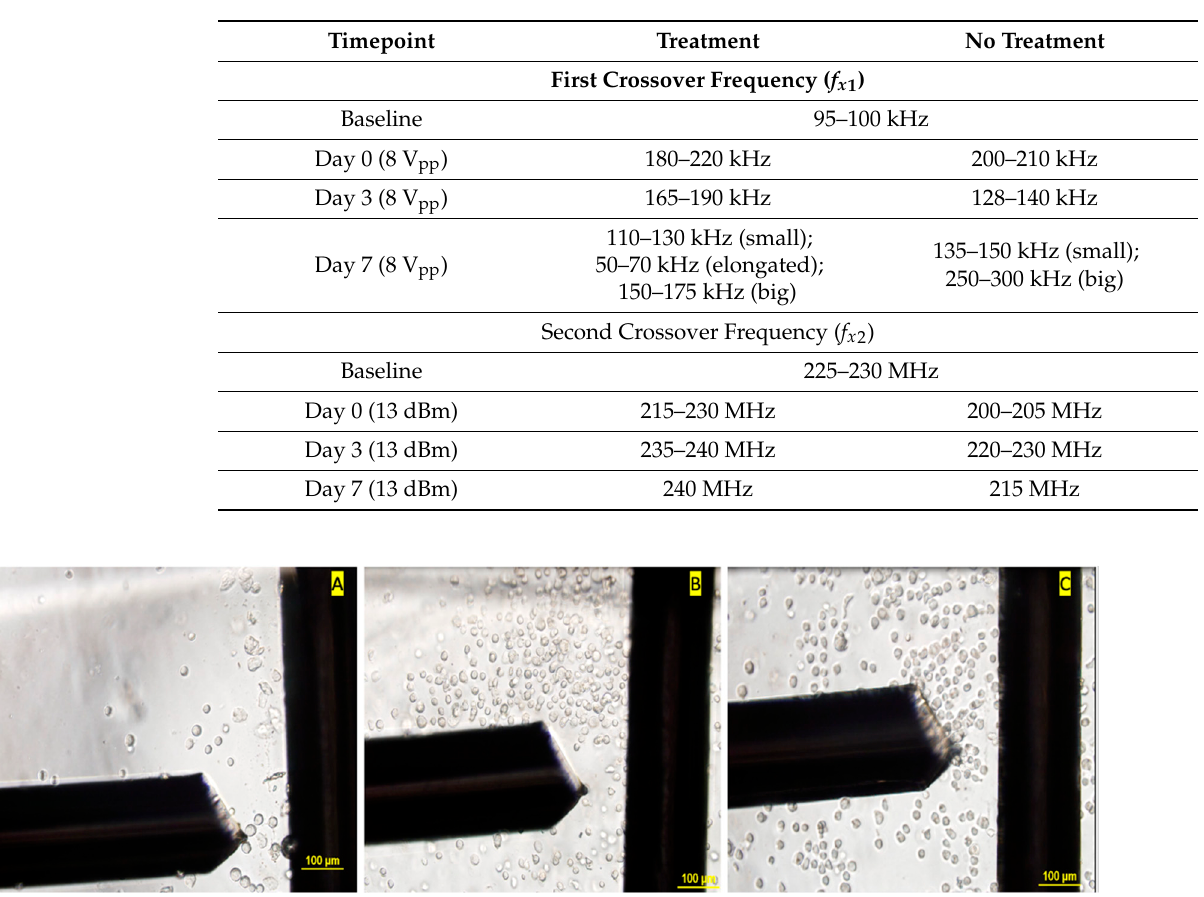
Table 1. Table reporting the stem cell first and second crossover experiment values for baseline and days 0, 3, and 7. Day 7 cells experienced extreme heterogeneity consisting of small, large, and elongated cell populations. The medium conduc- tivity for all the experiments was maintained at 0.06 S/m.